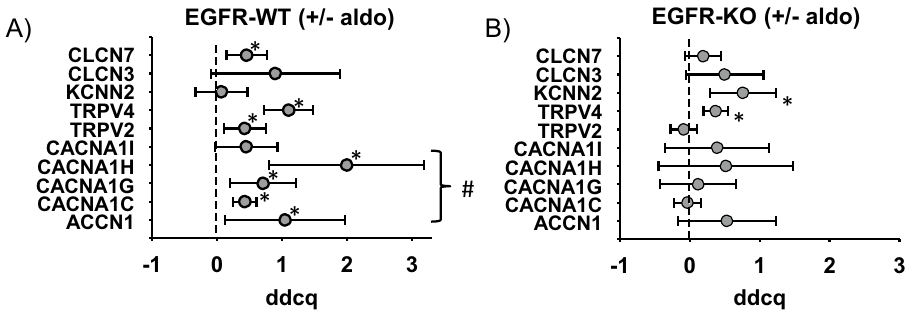
Figure 4. Aldosterone and EGFR-dependent differential expression of ion channels in cardiomyocytes. ( A ) Impact of in vivo aldosterone application on ion channel expression in freshly prepared cardiomyocytes of EGFR-WT mice determined by qPCR (ddcq = difference in quantitative cycles between normalized values of aldo and non-aldo animals) (N = 4–6; n = 8–12). All quantitative data represented as mean ± SEM; * p ≤ 0.05. EGFR-dependent aldosterone effects determined by comparison with results from EGFR-KO presented in ( B ) are labeled with (#). ( B ) Impact of in vivo aldosterone application on ion channel expression in freshly prepared cardiomyocytes of EGFR-KO mice determined by qPCR (ddcq = difference in quantitative cycles between normalized values of aldo and non-aldo animals) (N = 4–6; n = 8–12). All quantitative data represented as mean ± SEM; * p ≤